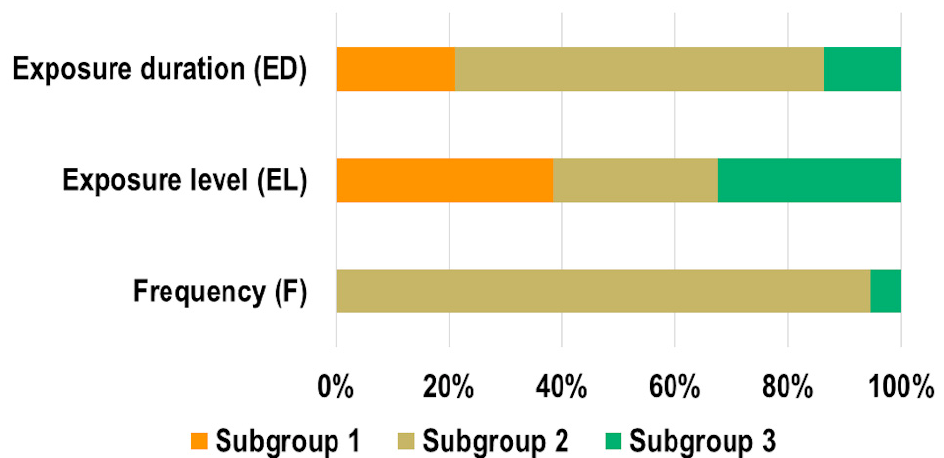
Figure 6. Percentage of experiments belonging to the three subgroups (ED1/ED2/ED3; EL1/EL2/EL3; F1/F2/F3) within the main exposure parameters. In the majority of experiments (84.7%), no statistically significant effects on the ana- lyzed endpoints were found; only the 15.3% reported statistically significant effects (Fig- ure 7a). The percentage of experiments reporting effects is presented in Figure 7b with respect to exposure parameters. The highest incidence occurred in the F3 subgroup, with 13 out of 14 experiments (belonging to two different studies) reporting significant effects. Regarding the exposure level and duration subgroups, the highest incidence was obtained for above limits (EL3, 30.1%) and acute exposures (ED1, 42.6%). The incidence of significant and non-significant effects with respect to the analyzed endpoints is shown in Figure 7c. (6 out of 12 experiments), followed by caspases activation (7 out of 32 experiments) and the observation of morphological hallmarks (2 out of 10 experiments). For the PE, apoptosis signaling and DNA fragmentation endpoints, the incidence of significant effects ranged from 10.6 to 14.3% (12 out of 113 experiments for PE; 7 out of 48 for apoptosis signaling; 3 out of 27 experiments for DNA fragmentation). Only two experiments assessed the membrane integrity endpoint and did not find significant effects. Only one experiment assessed expression of cytochrome-c and found a significant